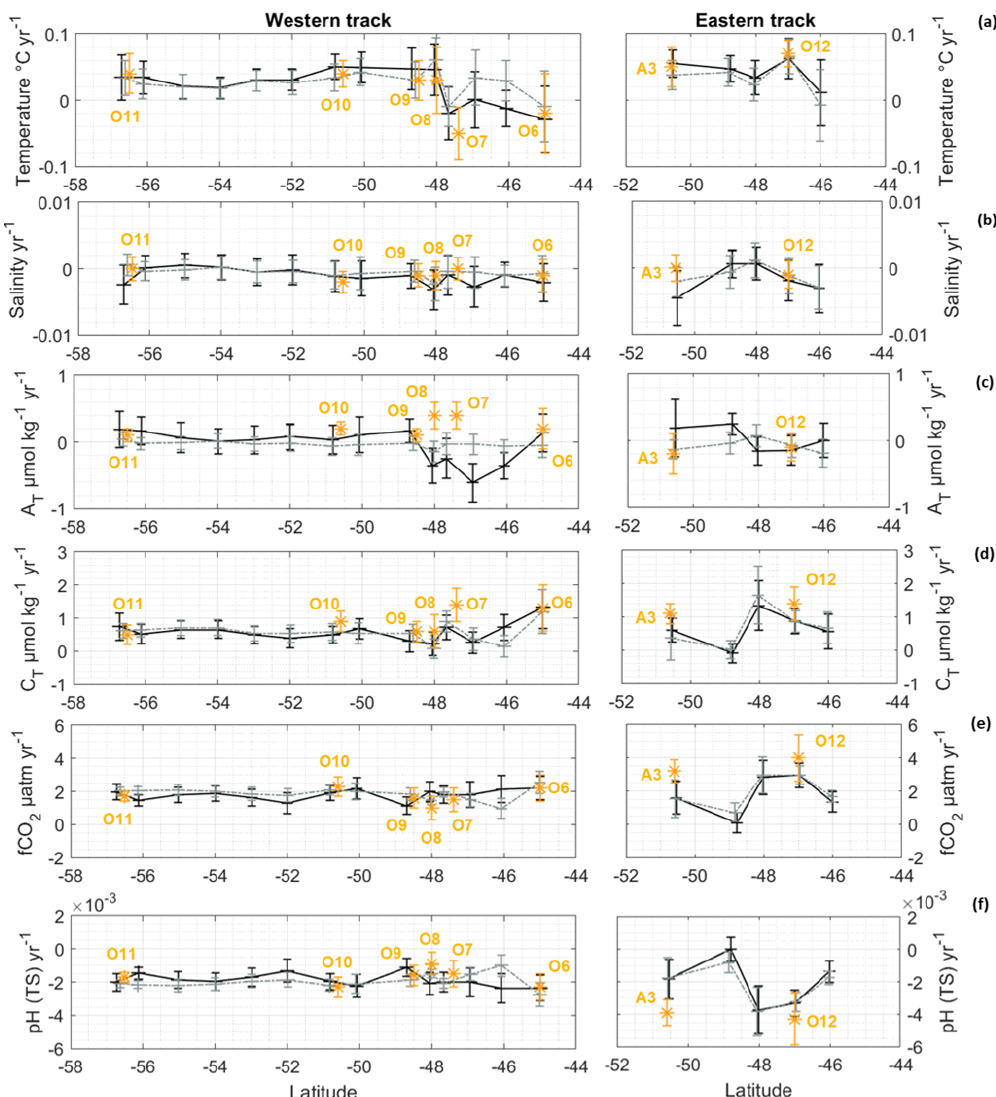
Figure 4. Trends (per year) of temperature (a) , salinity (b) , A T (c) , C T (d) , fCO 2 (e) and pH (f) evaluated from the fCO 2 surface dataset (in grey), the A T and C T surface dataset (in black), and the A T and C T data in the mixed layer at each station (in orange) along the western and eastern tracks (see Fig. S4 in the Supplement). The computation method is explained in the Sect.